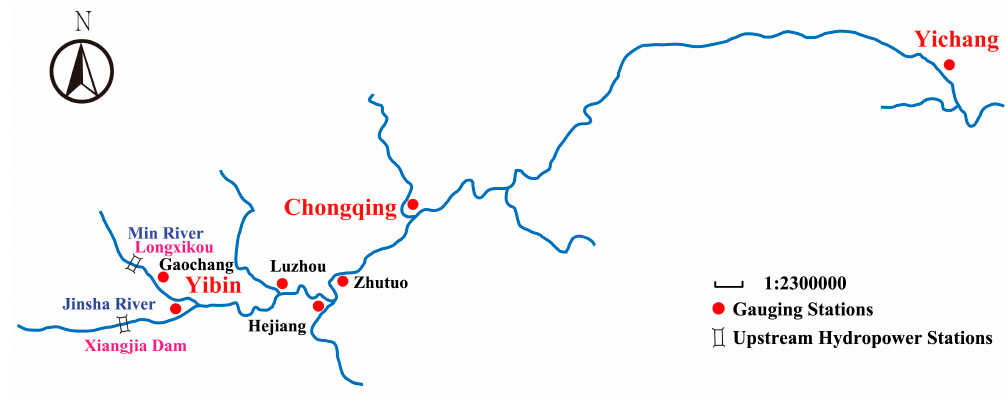
Figure 1. Site map of Yangtze River reach, key gauging stations and upstream hydropower stations.